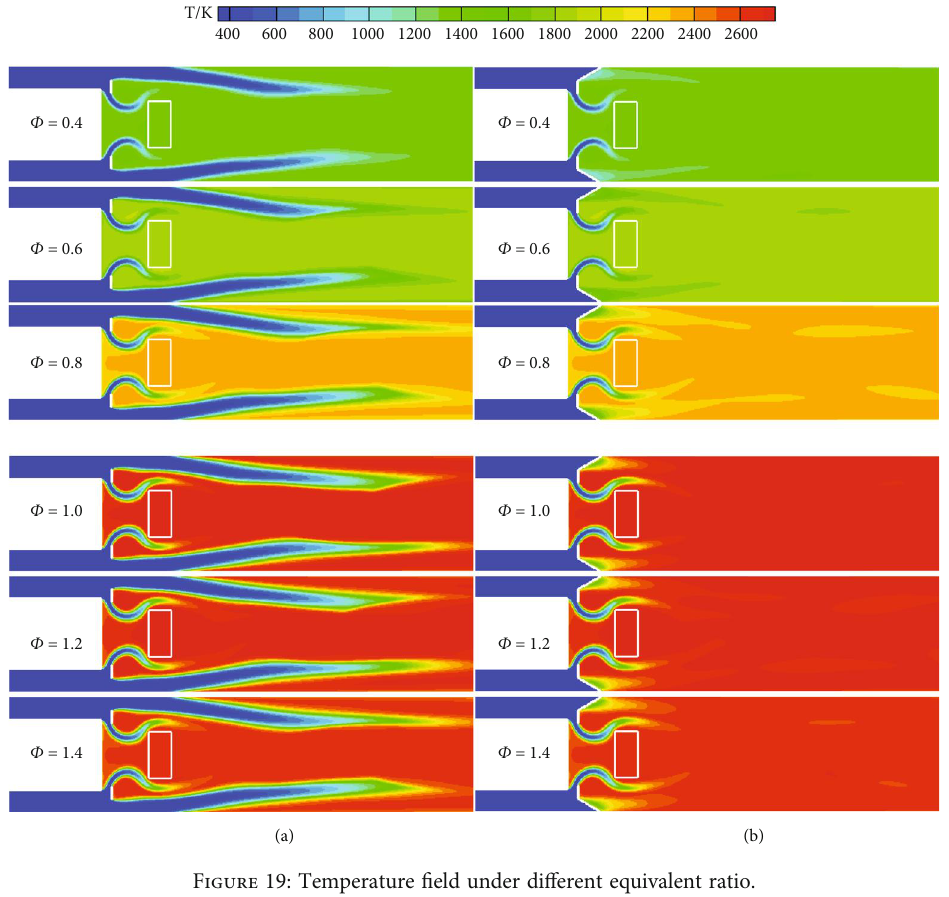
Figure 19: Temperature fi eld under di ff erent equivalent ratio.